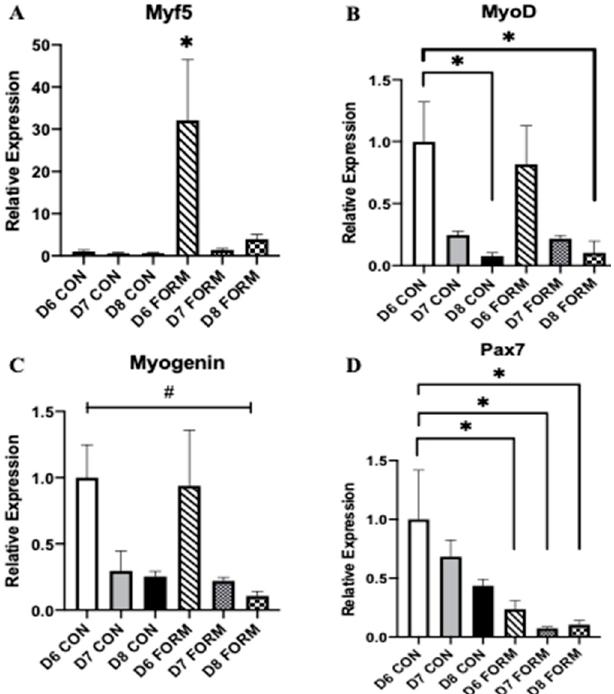
Figure 1. For each figure (n = 5), the symbol (*) is used to represent a significance difference between conditions and the symbol (#) is used to represent an overall significant effect for the ANOVA, with no significant differences between conditions. Myf5 ( A ): D6 FORM was increased compared to all other conditions ( p < 0.05). MyoD ( B ): D8 CON was decreased compared to D6 CON ( p = 0.025); D8 FORM was decreased compared to D6 CON ( p = 0.032). Myogenin ( C ): There was an overall significant effect observed ( p = 0.048; F = 2.775). Pax7 ( D ): D6 FORM was decreased compared to D6 CON ( p = 0.044); D7 FORM was decreased compared to D6 CON ( p = 0.008); D8 FORM was decreased compared to D6 CON ( p = 0.011).